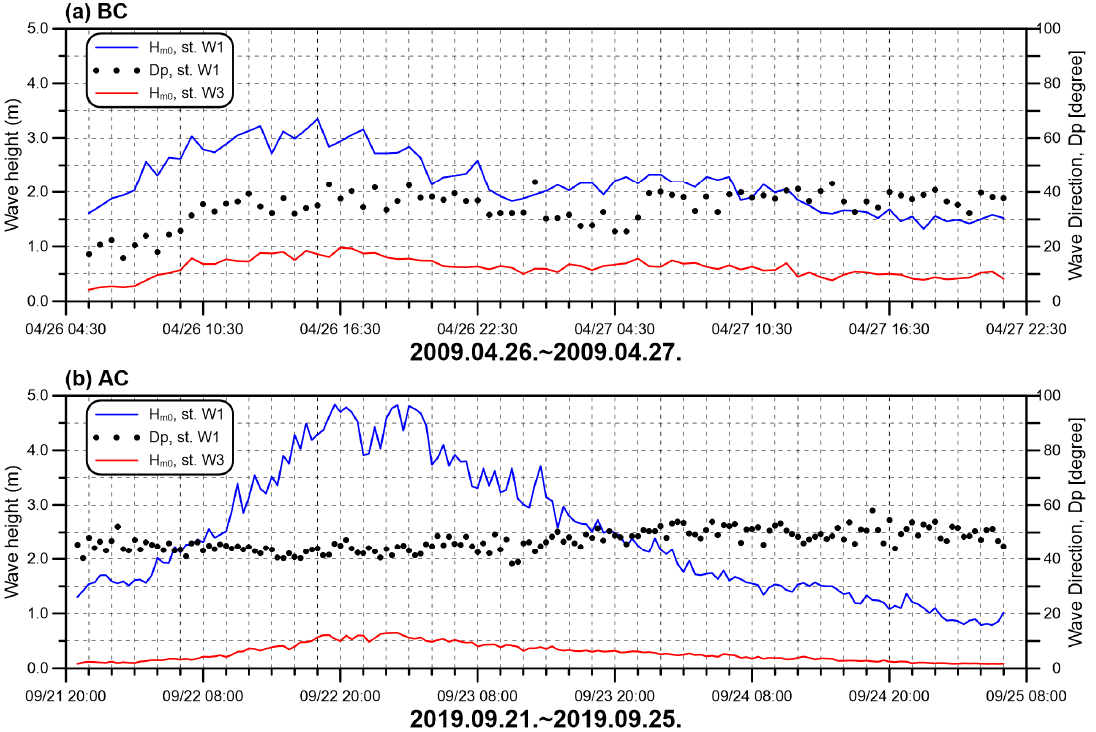
Figure 3. ( a ) 𝐻 (cid:3040)(cid:2868) (blue line) and 𝐷 (cid:3043) (black circles) in W1 and 𝐻 (cid:3040)(cid:2868) in W3 (red line) for a selected wave event in BC; ( b ) same as ( a ) but an event in AC. These two wave events were also selected for the numerical experiments, as described in Sections 2.3 and 3.2.